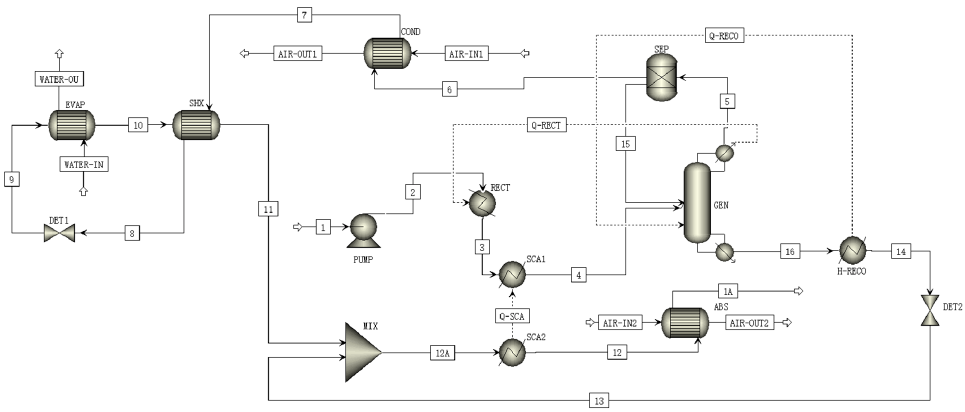
Figure 2. Aspen Plus simulation model for basic cycle. Table 1. Design conditions used in simulation design.